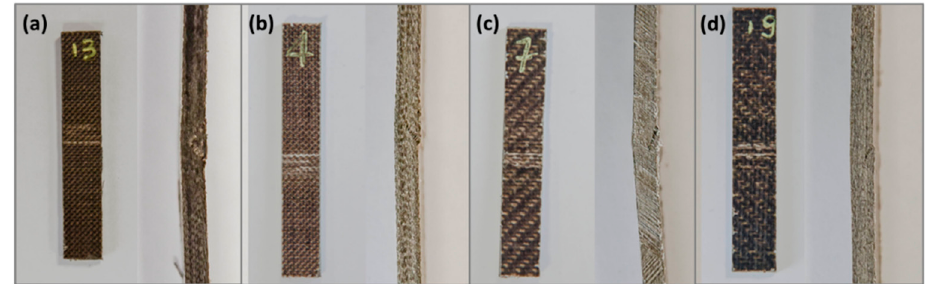
Figure 4. The specimens tested with a bending test: ( a ) Plain_TL, ( b ) Plain_P40, ( c ) Twill_TL, and ( d ) Twill_P40.